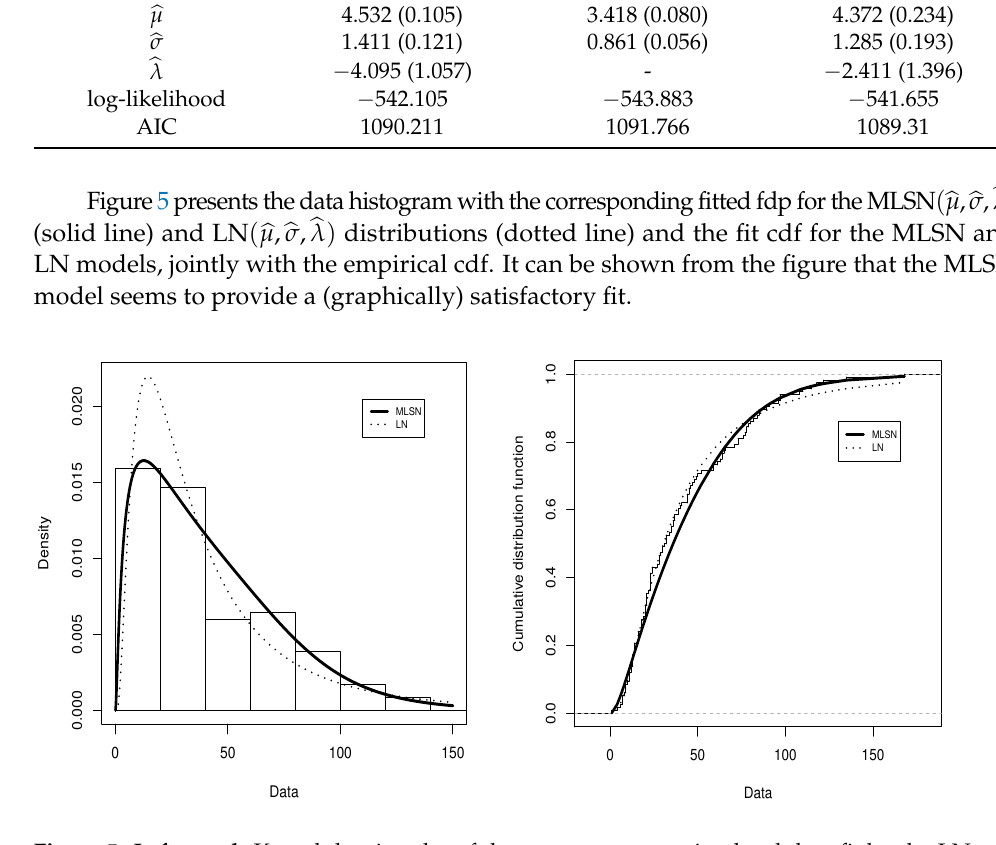
Figure 5. Left panel : Kernel density plot of the ozone concentration level data fit by the LN and MLSN distributions. Right panel : Empirical cdf of the LN (dotted line) and MLSN (solid line) models, whose parameters are estimated by the ML method for ozone concentration level data.